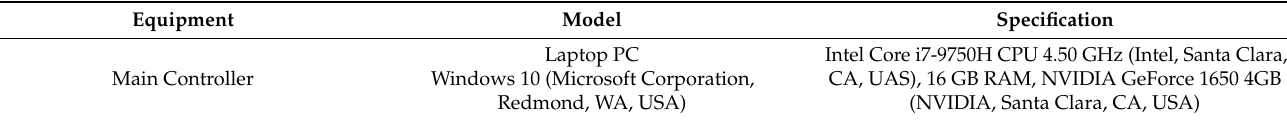
Table 1. Specifications of sensors, controller, and driving platform used in this study.